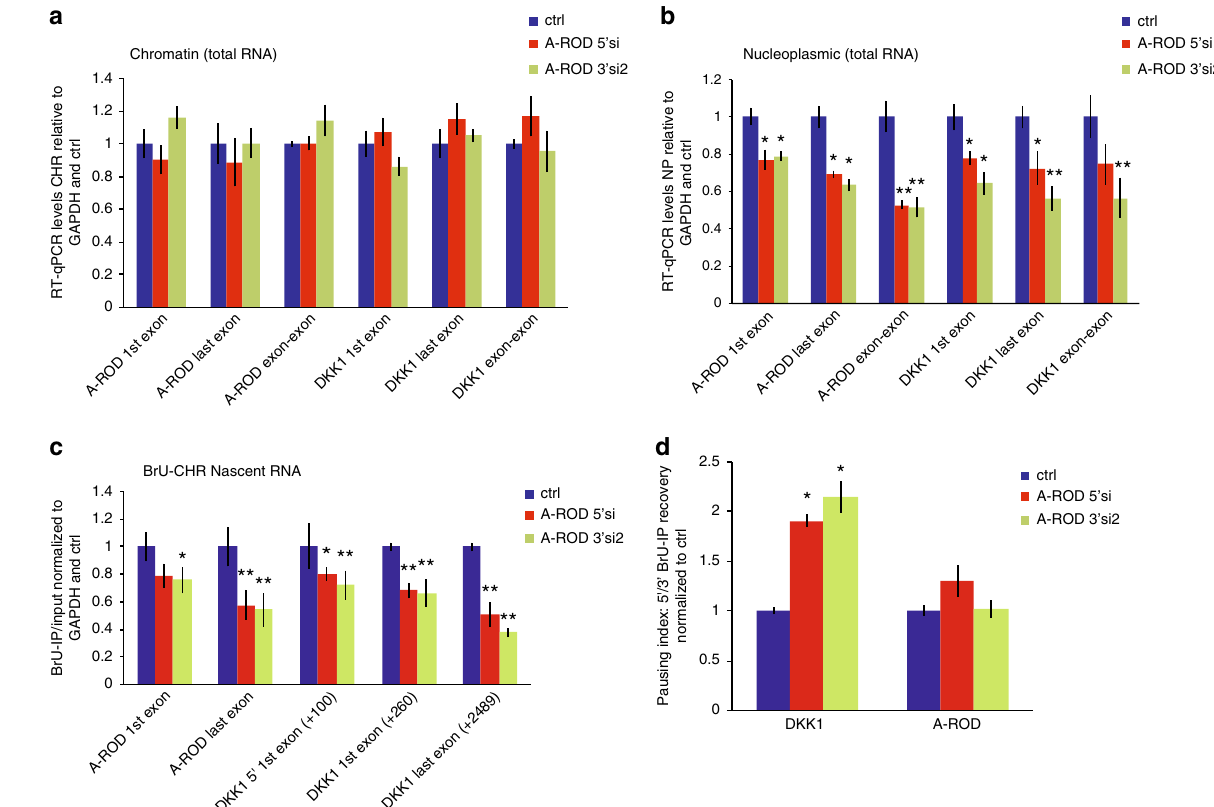
Fig. 4 A-ROD is functional at its release from chromatin. a , b Expression levels of A-ROD and DKK1 assessed upon cell fractionation in the chromatin- associated ( a ) and nucleoplasmic fraction ( b ), in control (ctrl) and siRNA-treated MCF-7 cells. RT-qPCR measured RNA levels are normalized to GAPDH and control. Two different siRNA sequences targeting either the 5 ′ (A-ROD 5 ′ si) or the 3 ′ (A-ROD 3 ′ si2) of A-ROD were used. Error bars represent standard deviations from three independent experiments (n = 3 biological replicates, * p < 0.05 and ** p < 0.01, two-tailed Student ’ s t -test). c Expression levels of A-ROD and DKK1 in the BrU-labeled nascent RNA (BrU IP done from the chromatin-associated RNA fraction) measured by RT-qPCR in control and A-ROD siRNA treated cells, assayed by two different siRNA sequences targeting either the 5 ′ (A-ROD 5 ′ si) or 3 ′ (A-ROD 3 ′ si2) of A-ROD. Values were normalized to GAPDH exon and control. Error bars represent standard deviations from three independent experiments ( n = 3 biological replicates, * p < 0.05 and ** p < 0.01, two-tailed Student ’ s t -test). d Transcriptional pausing index for A-ROD and DKK1 assessed by extracting the ratio 5 ′ /3 ′ IP recovery (BrU-IP over Input for two distinct 5 ′ and 3 ′ RT-qPCR amplicons) in control and A-ROD siRNA treated